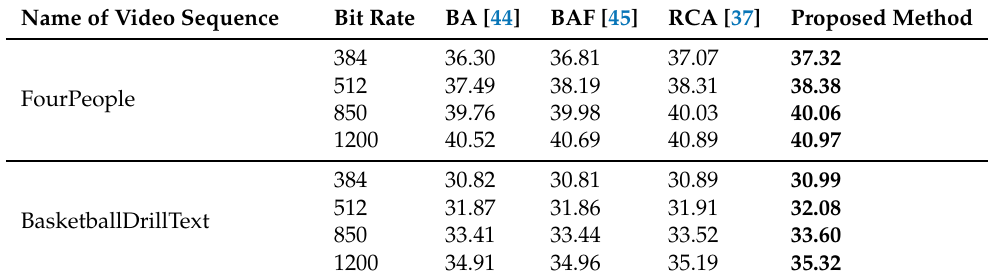
Table 6. PSNR Comparisons at different bit rates with other state-of-the-art rate control schemes. Name of Video